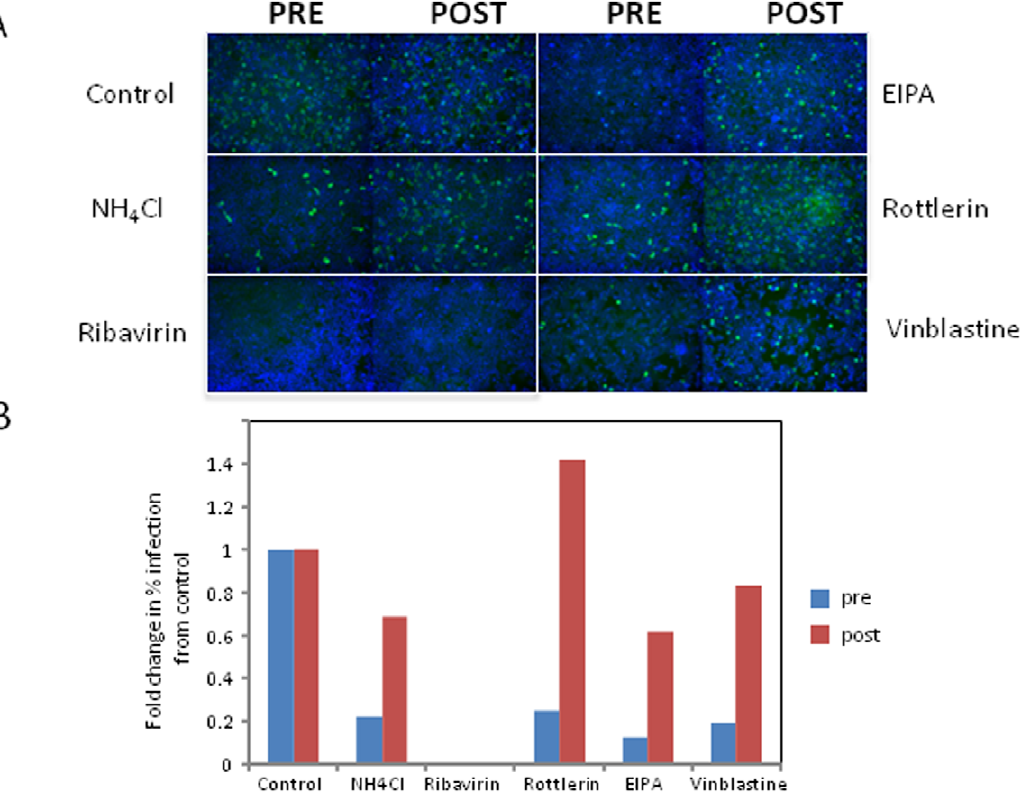
Figure 4. Time-of-Addition Assays. A . 293T/17 cells were either pre-treated with the indicated drugs or treated with drugs 1 hour post infection (MOI=0.3) for 12–15 hours. Representative images from cells treated with NH 4 Cl, Ribavirin, EIPA, Rottlerin and Vinblastine are shown. Cells stained with FITC anti-RVFV N (green) and counterstained with DAPI (blue). B . Quantification of the time of addition assay in A . was graphed to show the normalized percent infection for the indicated drugs tested. Blue bars are the pre-treatment, and red bars are the one hour post infection treatments.